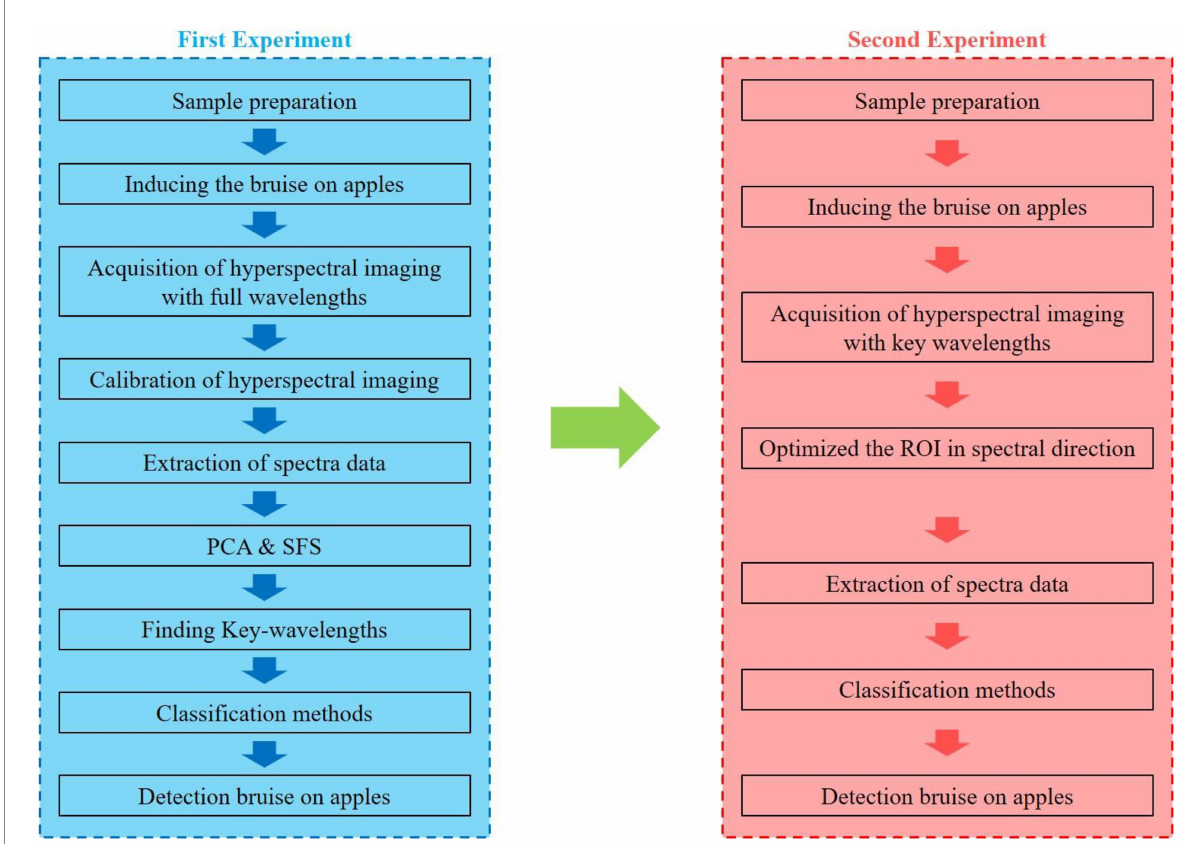
FIGURE 3 Key steps in the procedure used to find optimal wavelengths and spectrum resolutions to detect bruises on